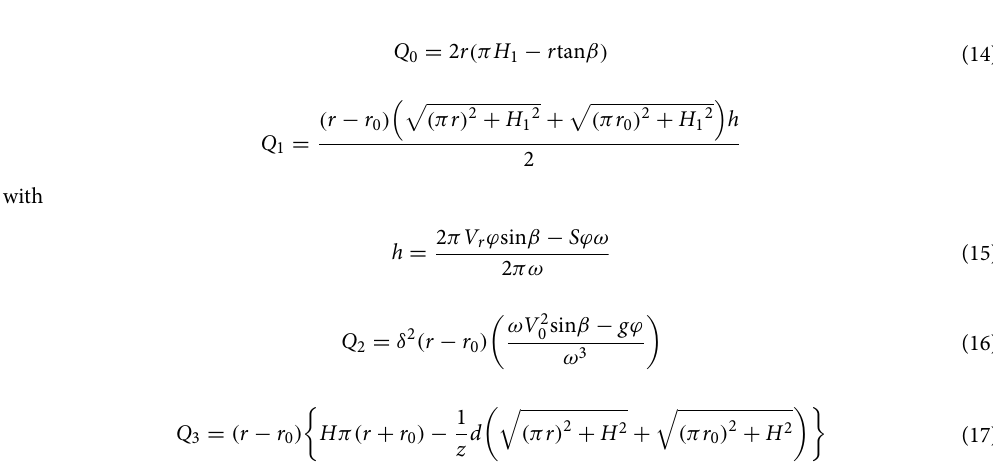
Figure 5. Description of virtual soil bin (Take 35° for example. All dimensions are in